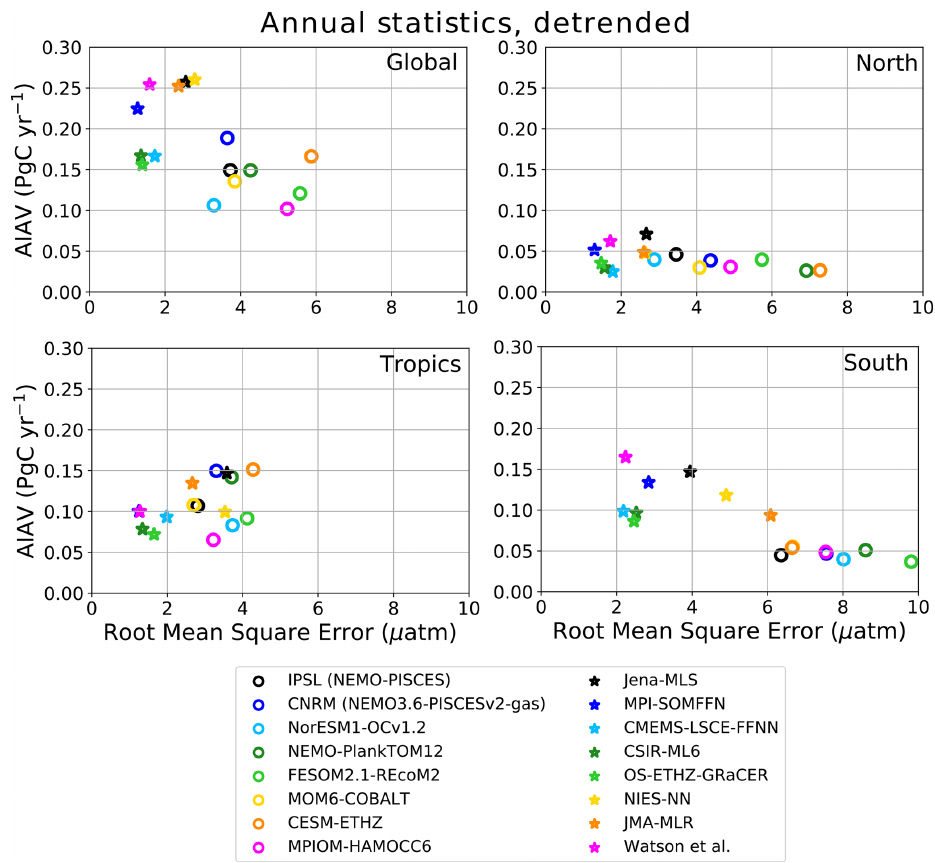
Figure B2. Evaluation of the GOBMs and data products using the root mean squared error (RMSE) for the period 1990 to 2020, between the individual surface ocean f CO 2 mapping schemes and the SOCAT v2021 database. The y axis shows the amplitude of the interannual variability (A-IAV, taken as the standard deviation of a detrended time series calculated as a 12-month running mean over the monthly flux time series, Rödenbeck et al., 2015). Results are presented for the globe, north ( > 30 ◦ N), tropics (30 ◦ S–30 ◦ N), and south ( < 30 ◦ S) for the GOBMs (see legend circles) and for the f CO 2 -based data products (star symbols). The f CO 2 -based data products use the SOCAT database and therefore are not independent from the data (see Sect.